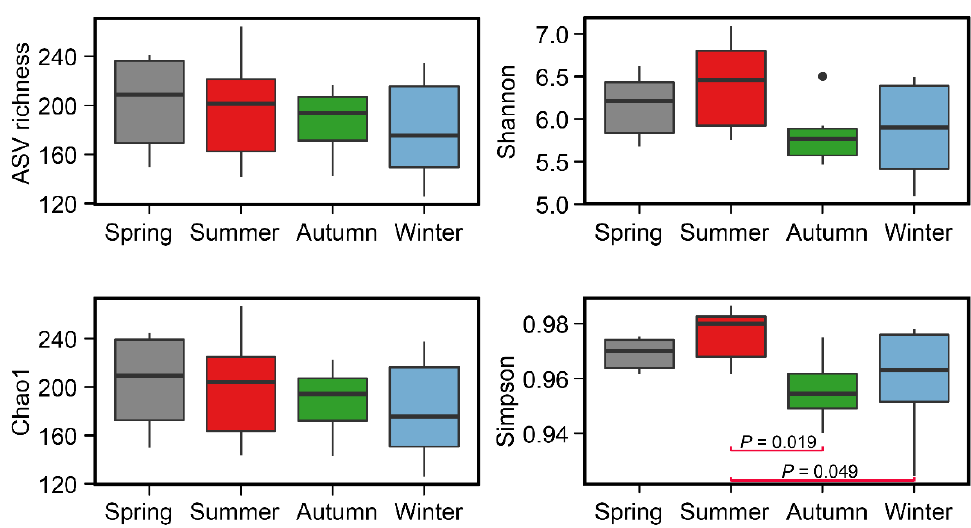
Figure 1. Comparisons of alpha diversity estimators of benthic archaea community. p values are given for the comparisons among seasons (spring, summer, autumn, and winter) using one-way ANOVA ( n = 6).